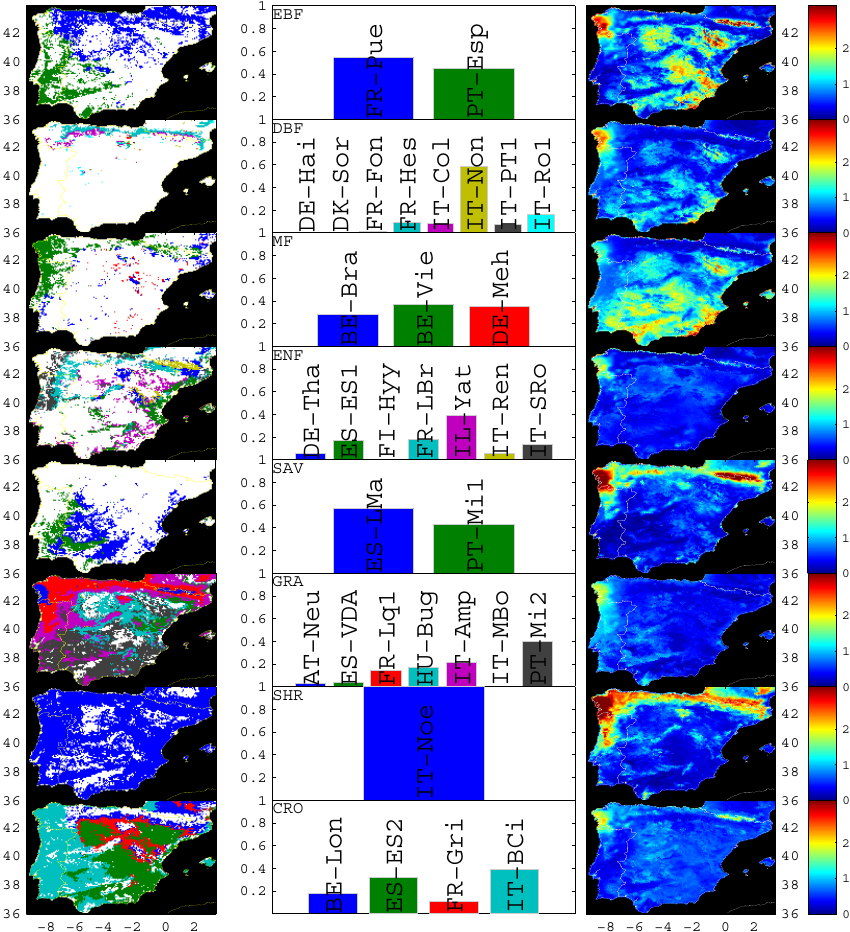
Fig. 4. The classification of the Iberian Peninsula according to the optimized eddy covariance sites per PFT (left column) is based on the selection of the closest site to each pixel. The distance (CP d ) maps per PFT show the minimum distance (CP d ) from the set of sites to the IP region (right column). Overall, the spatial classification shows a predominant selection of southern European and Mediterranean sites (middle column). Systematic higher distances (CP d ) in the NW IP are observed throughout PFT (right column). White regions in the left column maps indicate only a residual presence ( < 5%) of the respective